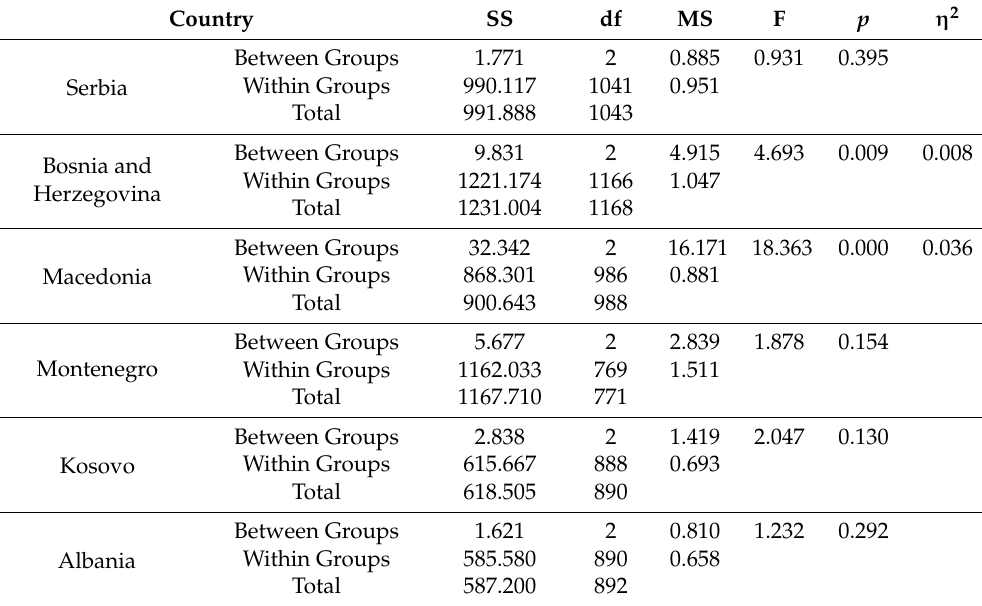
Table A16. Evading taxes among confessions by country.